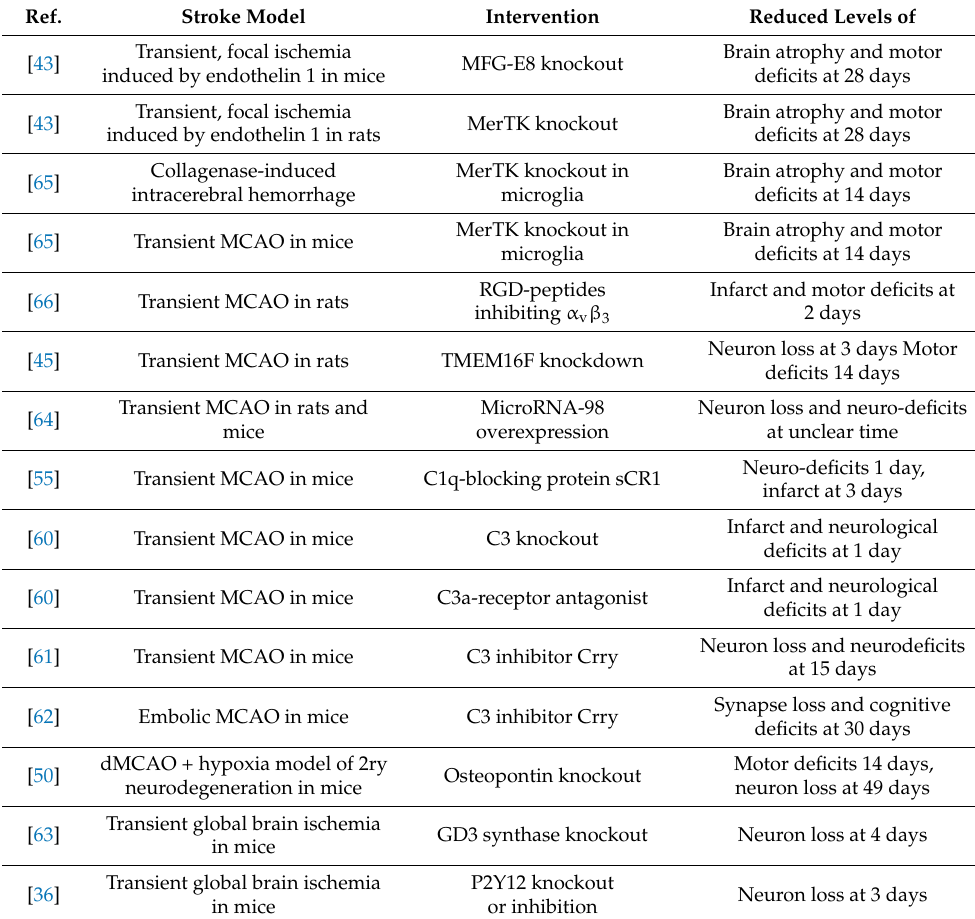
Table 2. Examples of interventions targeting microglial phagocytosis, which are of benefit in stroke